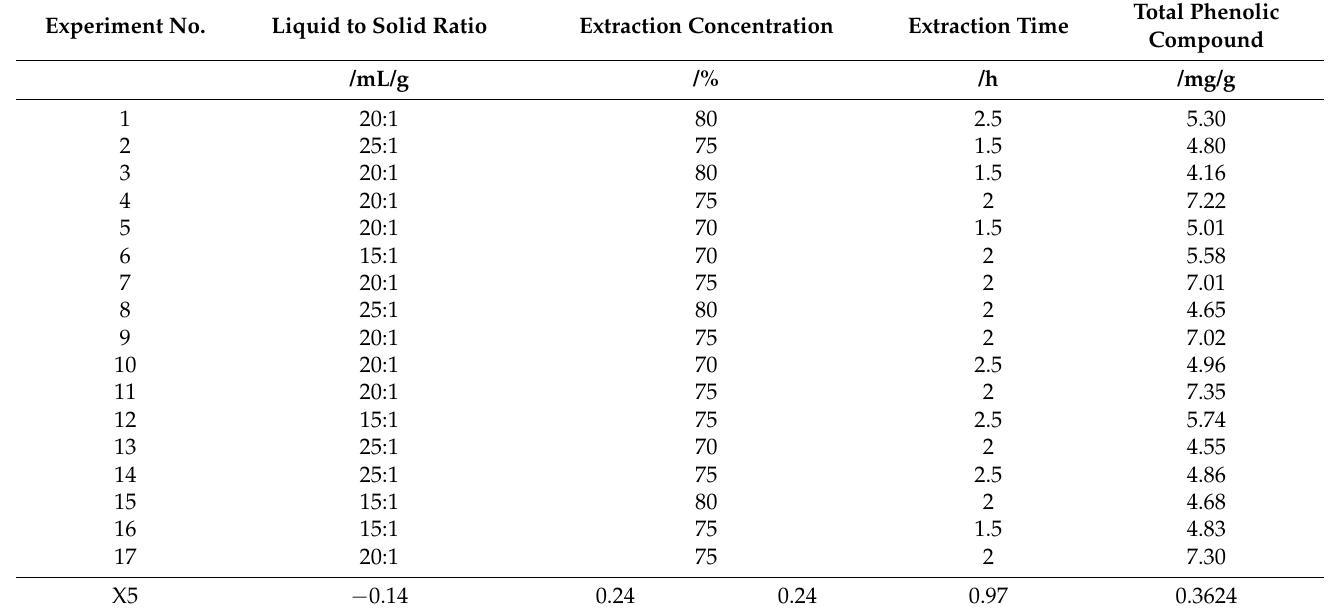
Table 5. Box–Behnken design (BBD) with the observed responses for yield of total phenolic. Experiment